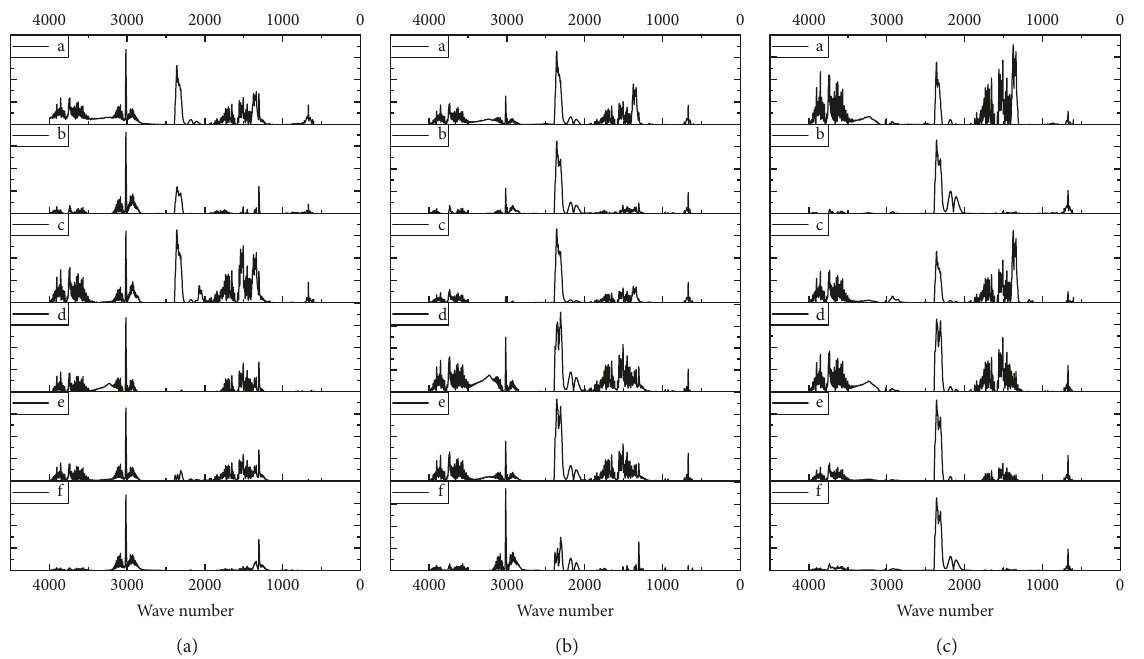
Figure 5: Comparison of the gas compositions of all coal samples at three